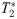
Simulations for the expected accuracy and precision ofT1 and T2* maps at SNR = 50.Rows refer to T1 (a, b) and T2* (c, d) simulations, while columns indicate the choice of the simulation parameters reflecting the acquisition: ME-MP2RAGE (a, c), MP2RAGE (b) or ME-FLASH (d). Each panel contain a plot of the estimated relaxation time as a function of the exact value, with the error bars indicating the standard deviations, σT, for N = 20000 simulations. The distance from the identity line indicates the expected accuracy, while the size of the error bars reflect the expected precision. For T1 / exponential recovery simulations, the range 0.5–3.5 s was probed, and the exact acquisition parameters simulated were TI,(1,2) = 800, 2400 ms for ME-MP2RAGE, and TI,(1,2) = 750, 2900 ms for MP2RAGE. For T2 / exponential decay simulations, the range 2–60 ms was probed, and the exact acquisition parameters simulated were nE = 4, TE,1 = 2.5 ms, ΔTE ≈ 4.2 ms for ME-MP2RAGE, and nE = 5, TE,1 = 3.0 ms, ΔTE = 6.0 ms for ME-FLASH.